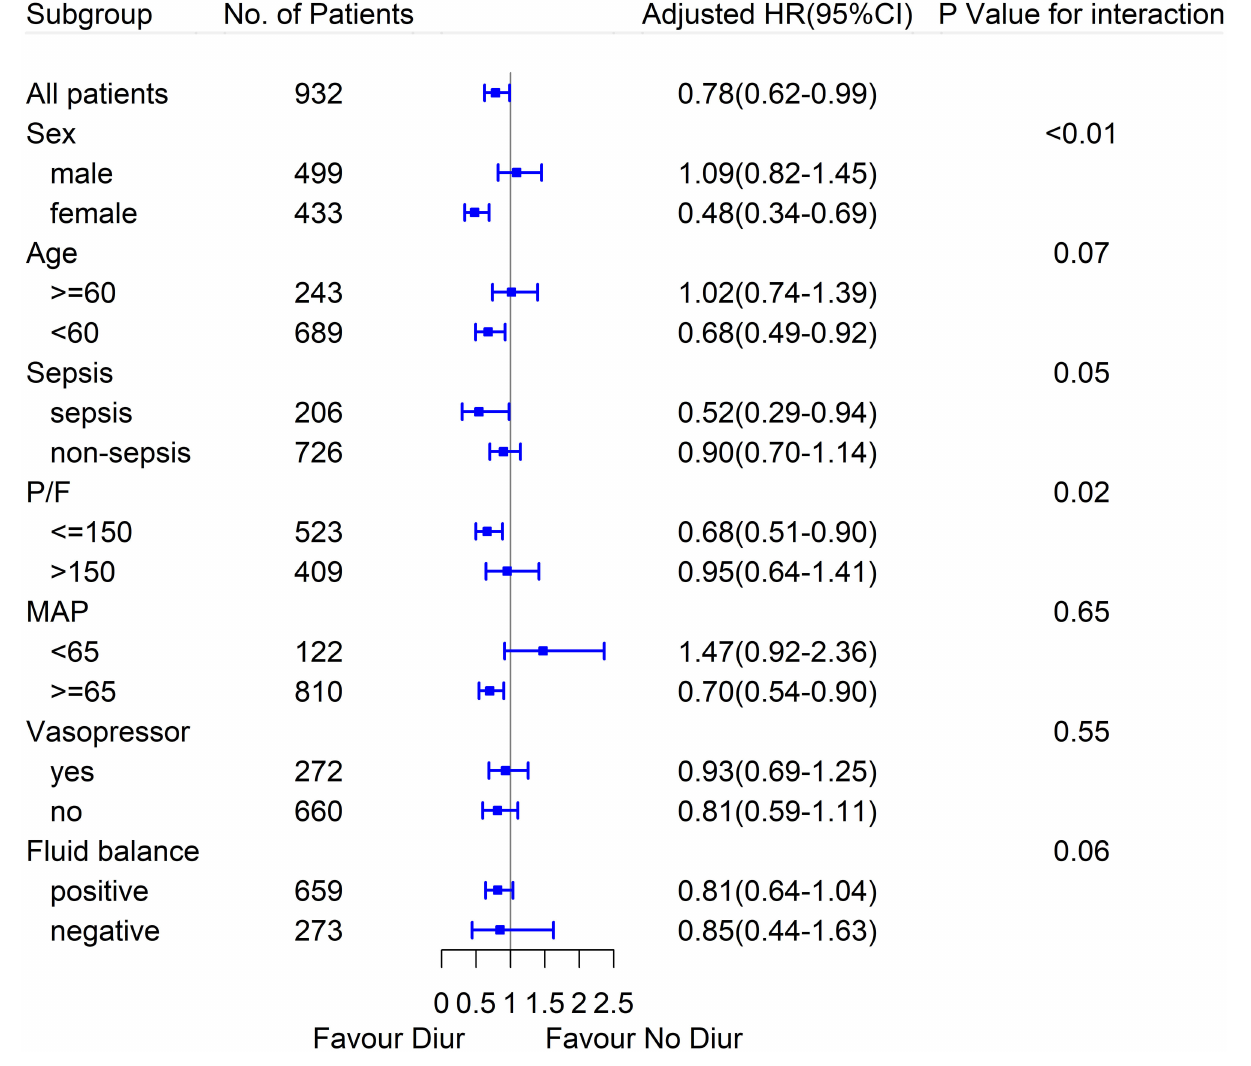
significantly lower in the diuretics group [84 (15.1%) vs.